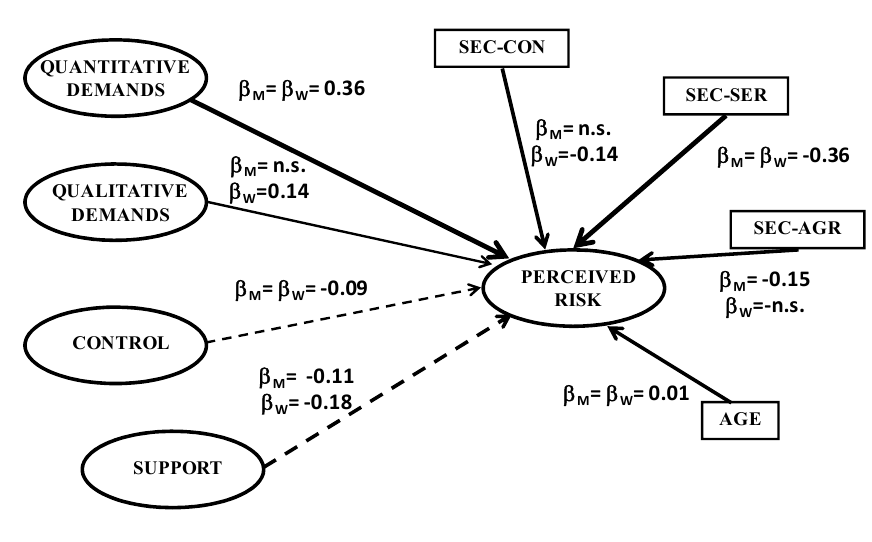
Figure 1. Structural